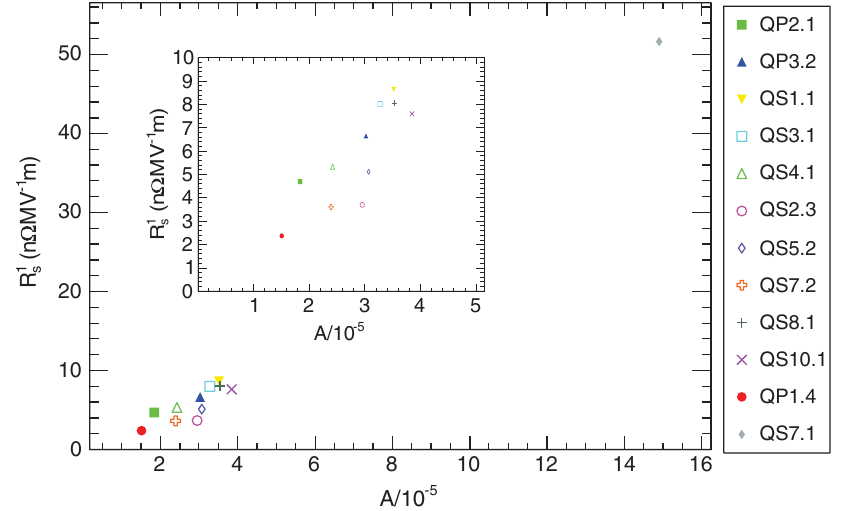
FIG. 7. Plot of R 1 s as a function of A . The insert allows an expanded view of all cavities except QS7.1.